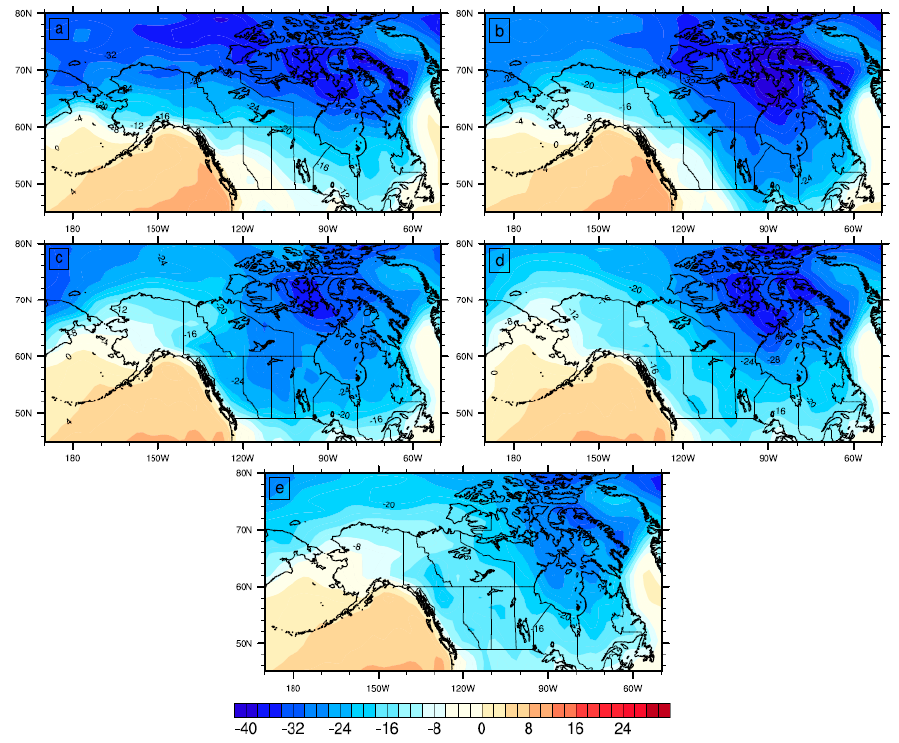
Figure 4. Surface air temperature (°C) in ( a ) 1–15 January; ( b ) 16–31 January; ( c ) 1–14 February; ( d ) 15–28 February; ( e ) 1–11 March, 2019.